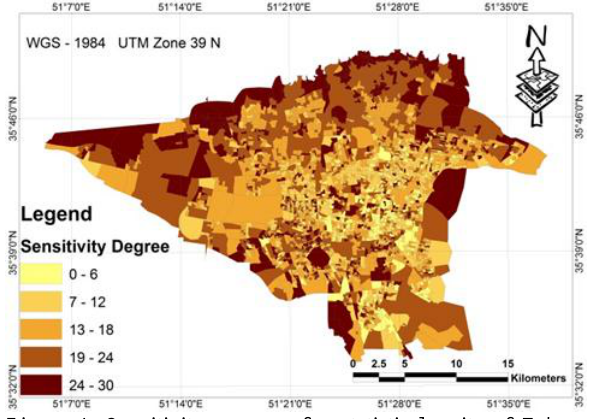
Figure 4. Sensitivity measure for statistical units of Tehran Metropolitan